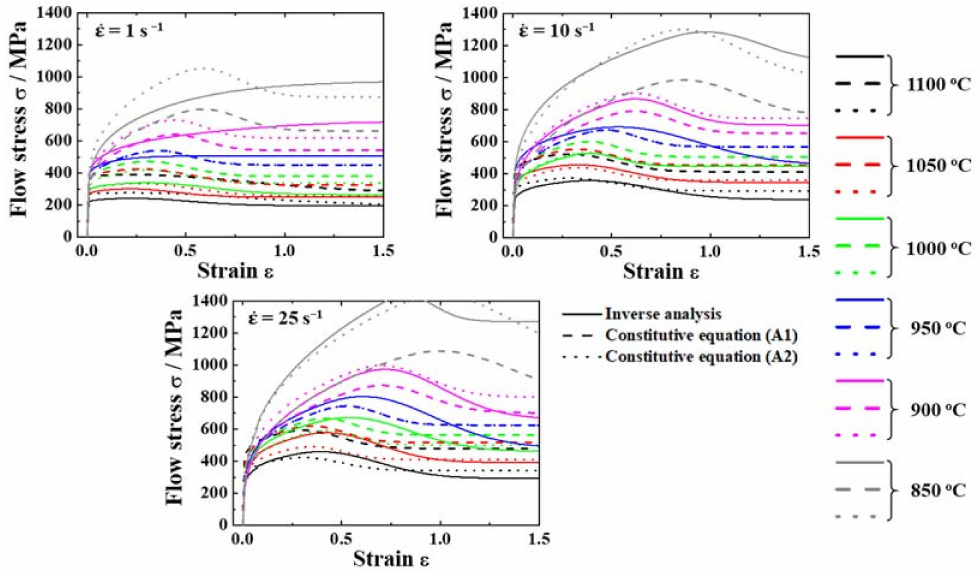
Figure 10. Flow curves obtained from results of IA and CEs calculated using temperature sensitivities A 1 and A